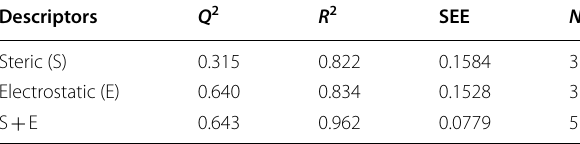
(D), and hydrogen bond acceptors (A) are shown in Table 10. Furthermore, the CoMSIA-SED model revealed the highest Q 2 score of 0.702 with three components, an R 2 value of 0.877, and a relatively low SEE value of 0.1318. However, the best models among the possible CoMSIA